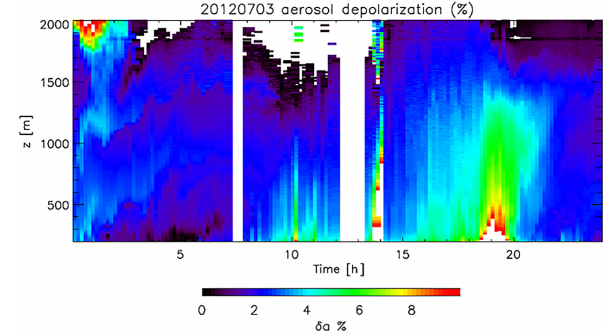
Figure 8. Mean daily evolution of aerosol particle volume size dis- tribution on dust-free days from the APSS at SPC.